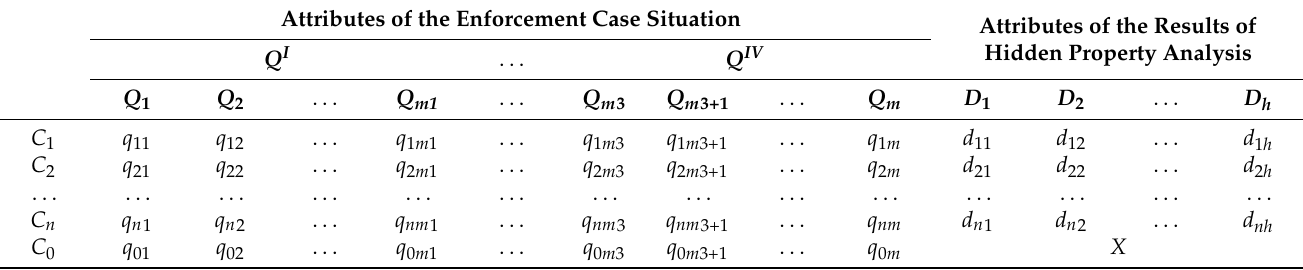
Table 1. Presentation of historical enforcement cases C i and target enforcement case C 0 . Attributes of the Enforcement Case Situation Attributes of the Results